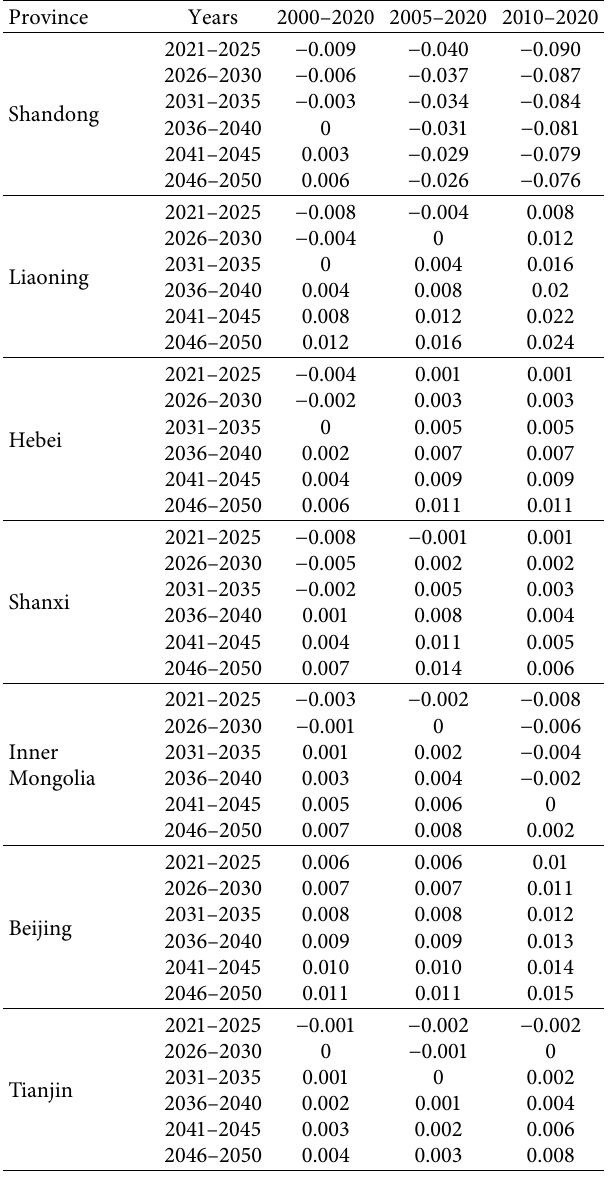
Table 4: Prediction of α parameter under three